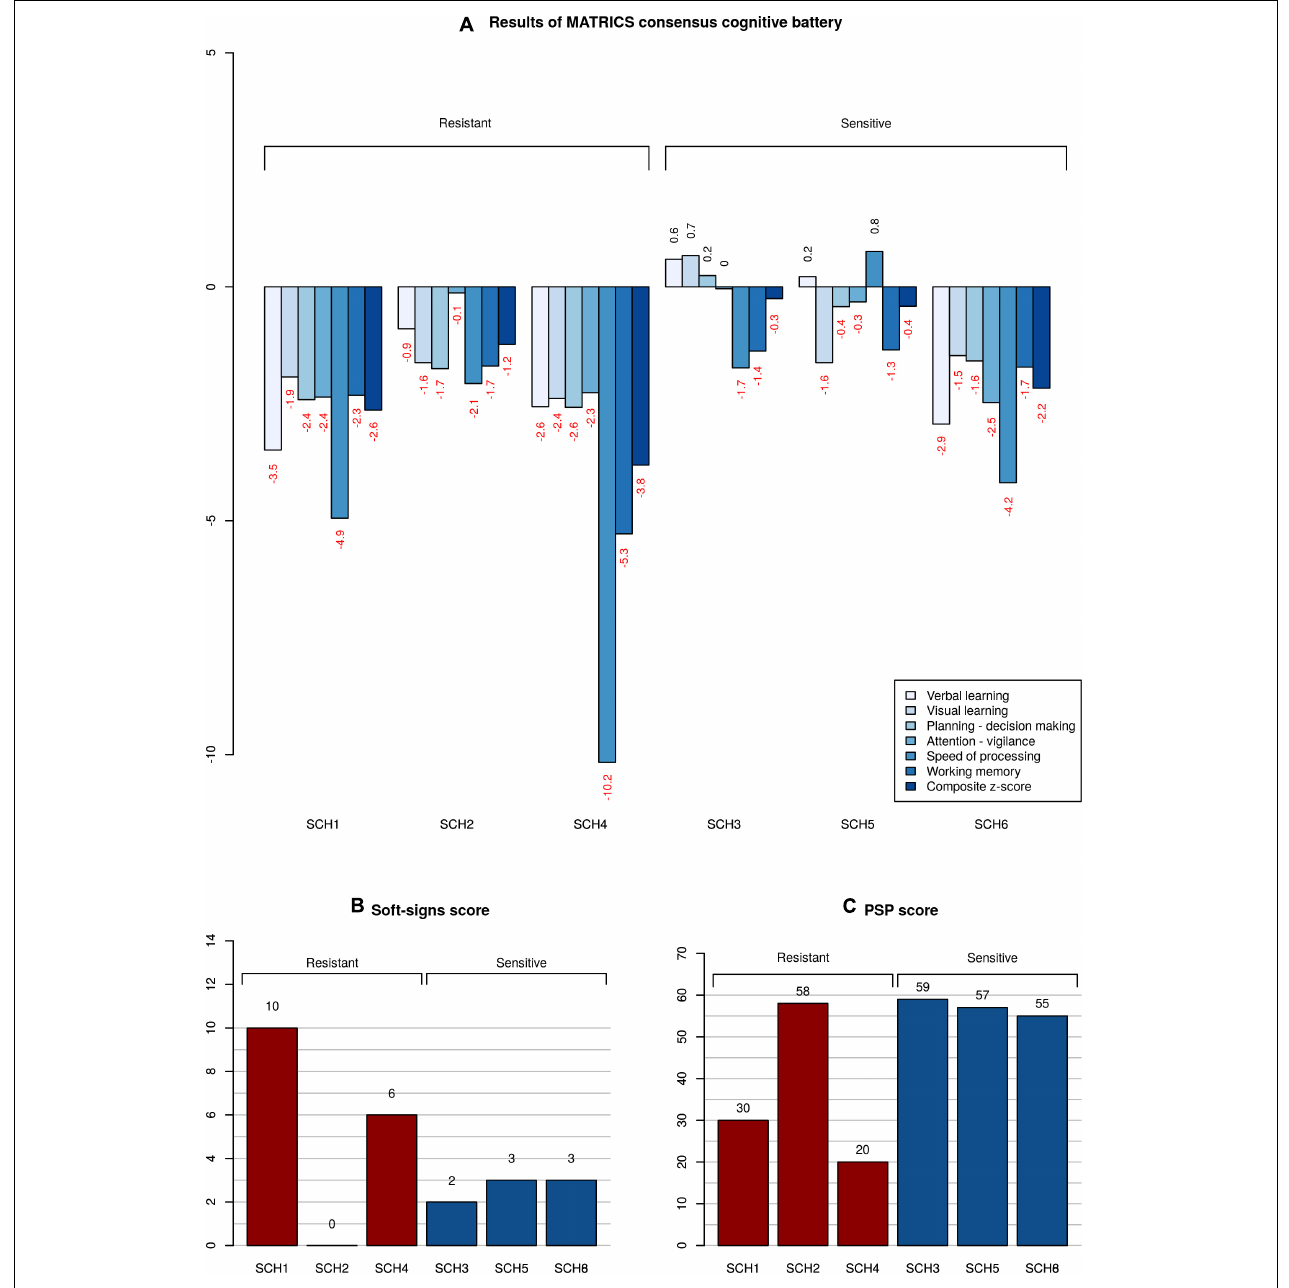
FIGURE 1 | Neuropsychological, psychosocial, and neurological functioning of patients. (A) Z-scores of clozapine resistant and sensitive patients in comparison with a cohort of healthy subjects. Subtests of MATRICS battery are color-coded; the composite score calculated from all the subtests is the right-most column. (B) Magnitude of neurological soft signs expressed as a total Neurological evaluation scale score. The higher the score, the more severe the neurological abnormality. (C) Level of functioning given as a Personal and Social Performance scale score. The higher the score, the better the overall functioning.